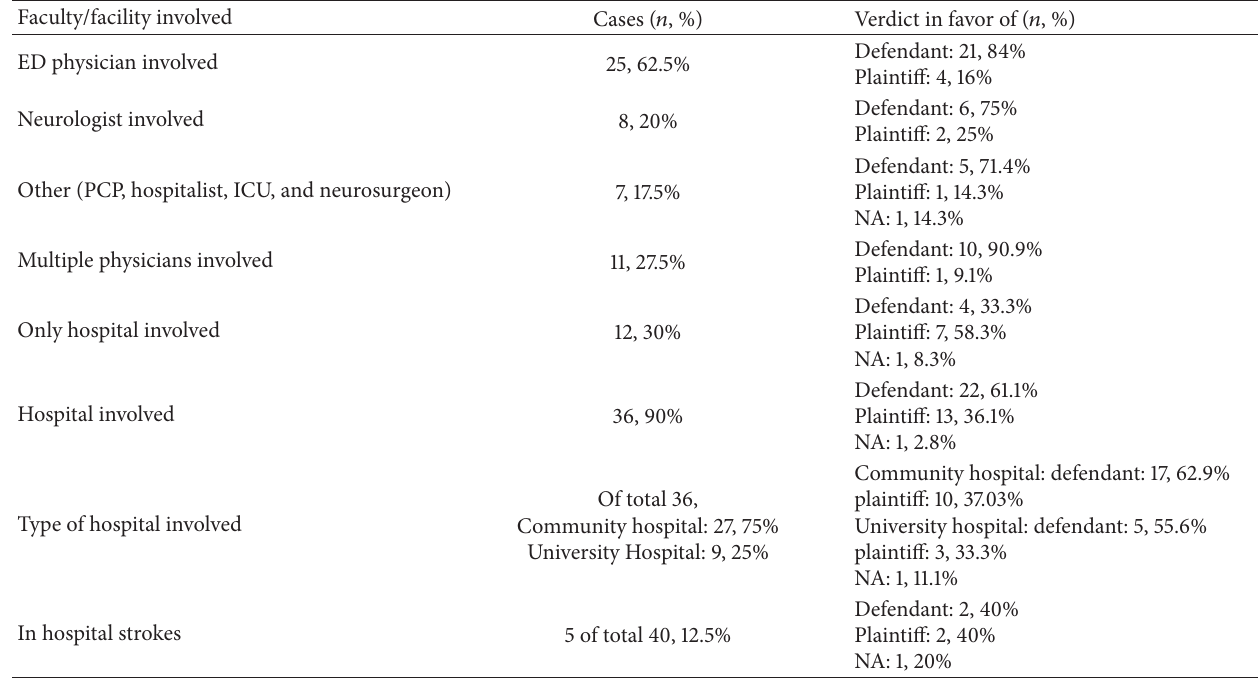
Table 2: Physician/facility involved.